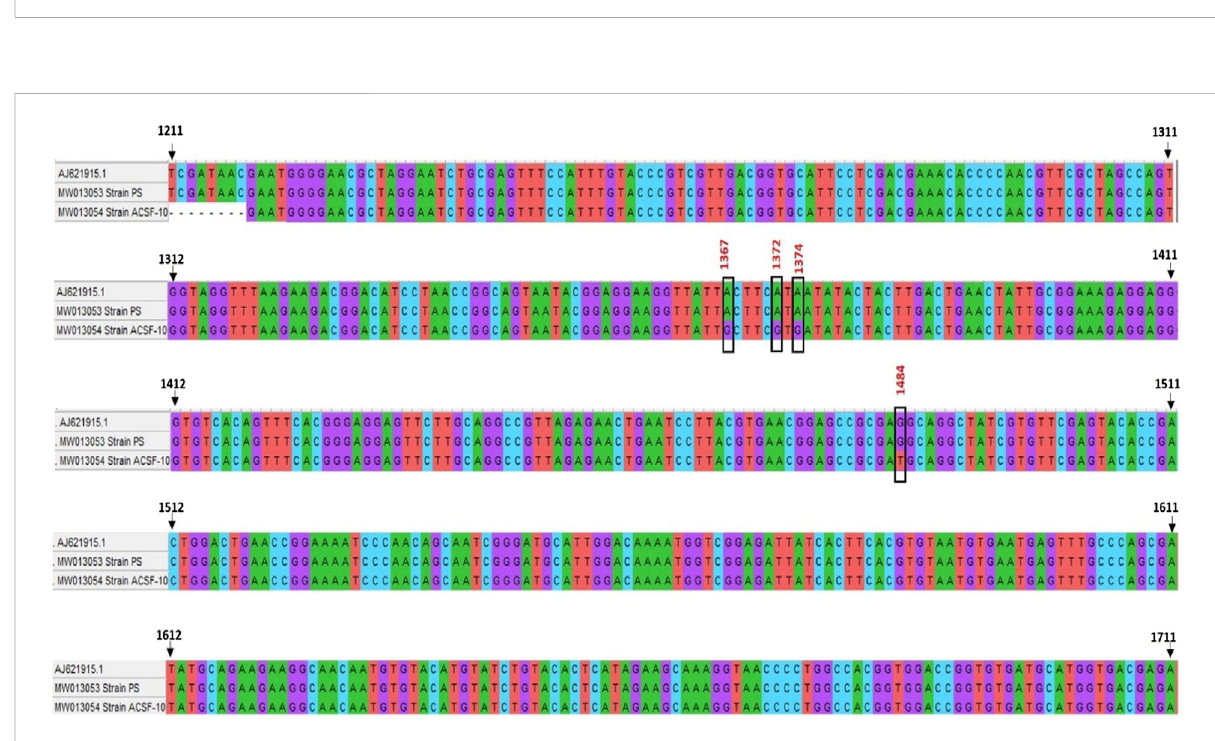
FIGURE 7 Frequency distributionoftheabsorbance values ofAChE activityinhibition inPS (parent susceptible), ACSF-5 (acetamipridlarval-selected fi lial- 5), and ACSF-10 (acetamiprid larval-selected fi lial-10) strains of Aedes aegypti ( n = 100). The susceptibility threshold is based on maximum absorbance in PS strain. The shaded region represents the resistant population (beyond the threshold). n = number of larvae; RP = resistant